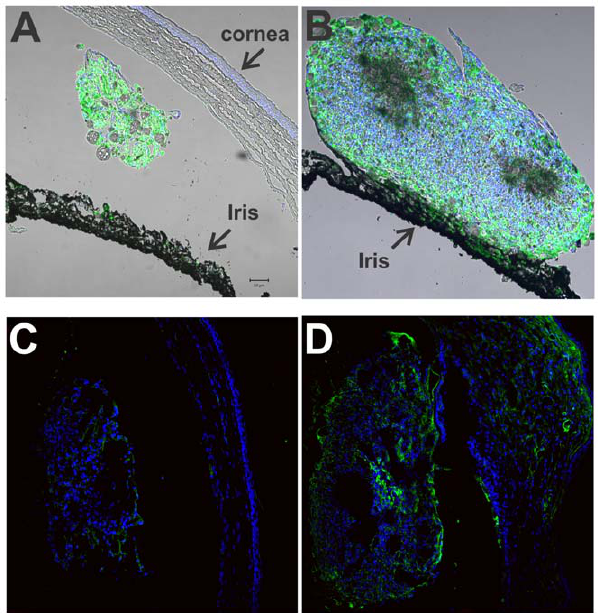
Figure 7. Localization of CD68 positive cells and VEGF in Ch and 7KCh implants. Rat eyes were implanted with 20% Ch and 7KCh wafers and cryosections prepared 14 days post implantation. The sections were labeled with AlexaFluor 488 (green) for anti-CD68 or anti- VEGF and the nuclei stained with DAPI (blue). A. Ch implant, anti-CD68. B. 7KCh implant, anti-CD68. C. Ch implant, anti-VEGF. D. 7KCh implant, anti-VEGF.